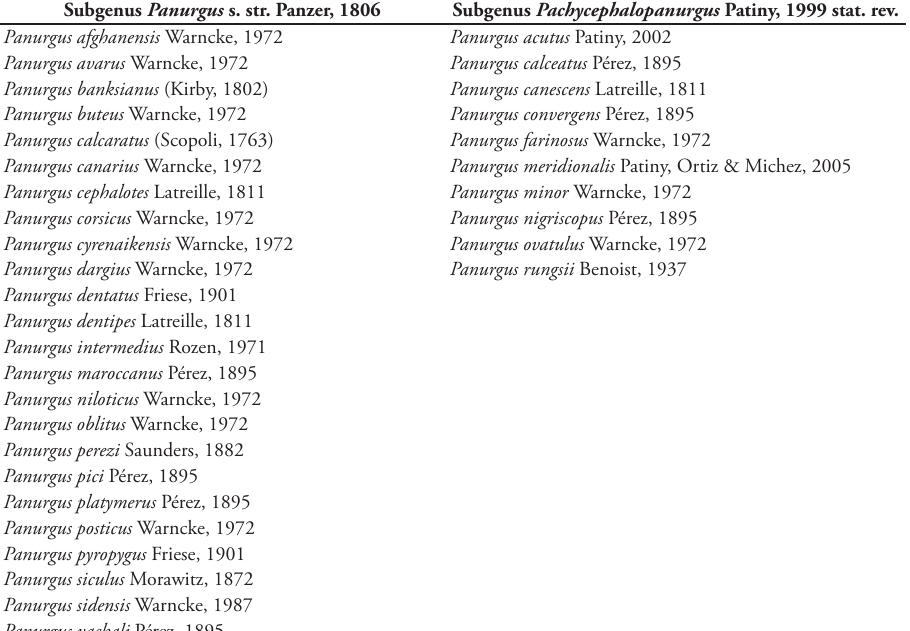
Table 2. Revised subgeneric classification system for the genus Panurgus , with all globally known species. Subgenus Panurgus s. str. Panzer,